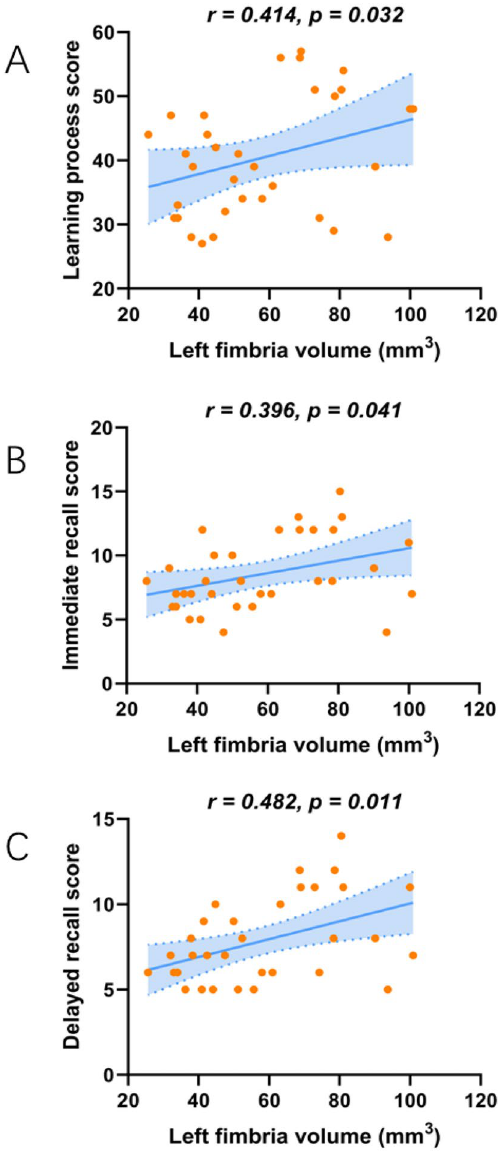
Figure 3. Volume of the left fimbria was correlated with learning process scores ( r = 0.414, p = 0.032) ( A ), immediate recall scores ( r = 0.396, p = 0.041) ( B ) and delayed recall scores ( r = 0.482, p = 0.011) ( C ). Adjusted age, gender, education, eTIV and hypertension and diabetes